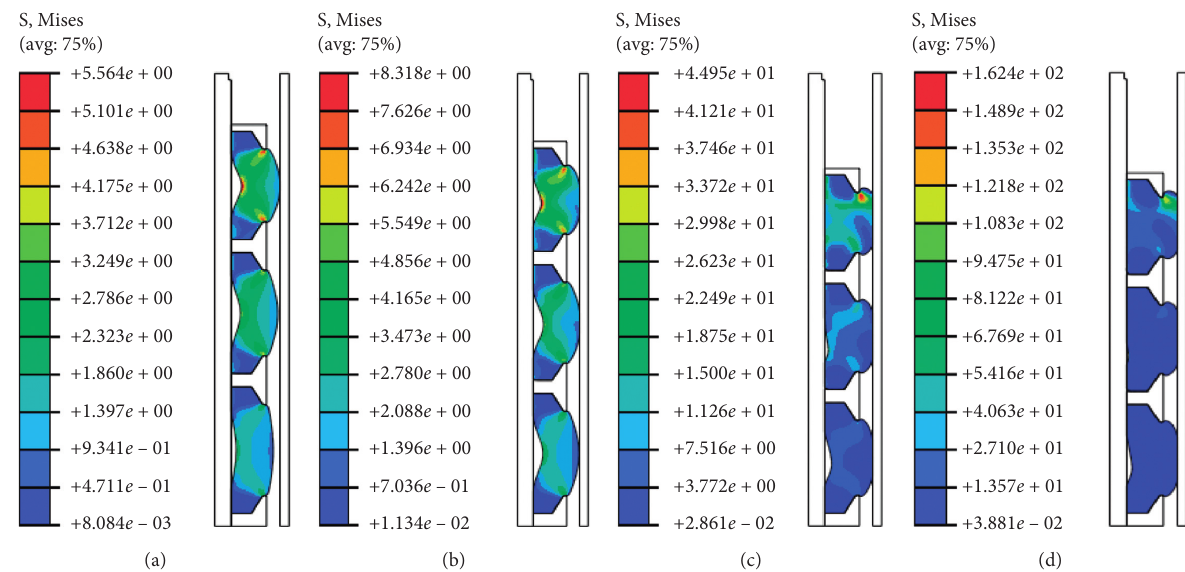
Figure 10: Stress change of the long rubber cylinder at different seating times. (a) t � 3s. (b) t � 5s. (c) t � 7 s. (d) t � 9 s.